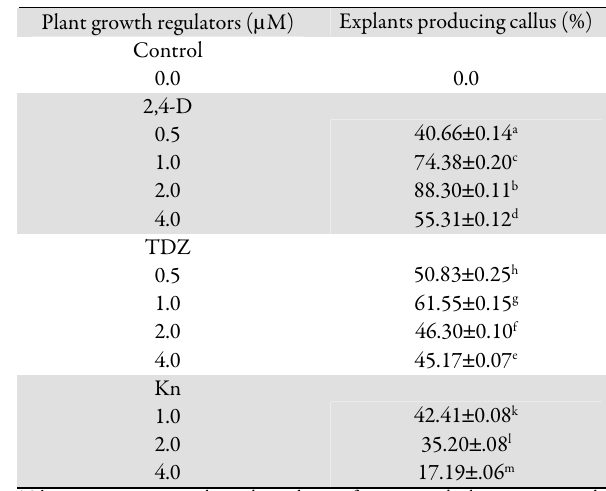
Tab. 1. The effect of different plant growth regulators on the morphogenic responses from the TCS explants of Zingiber officinale *